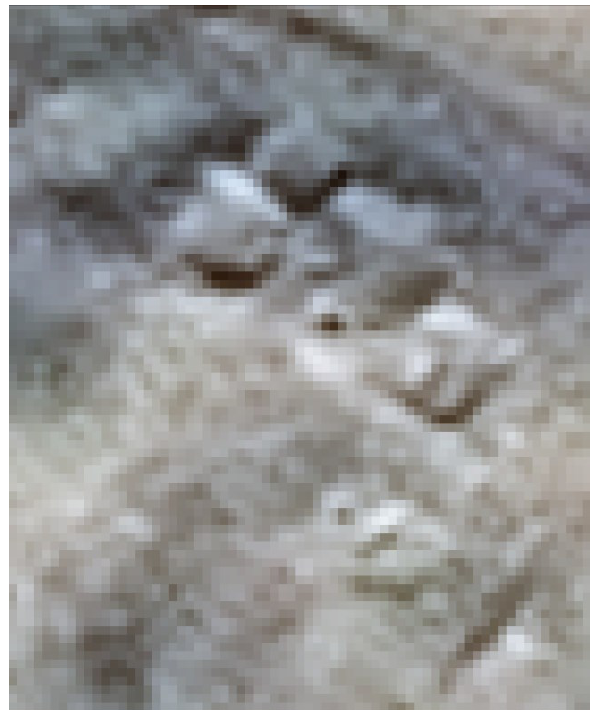
Figure 5. Raster DTM created from Pleiades satellites imaging